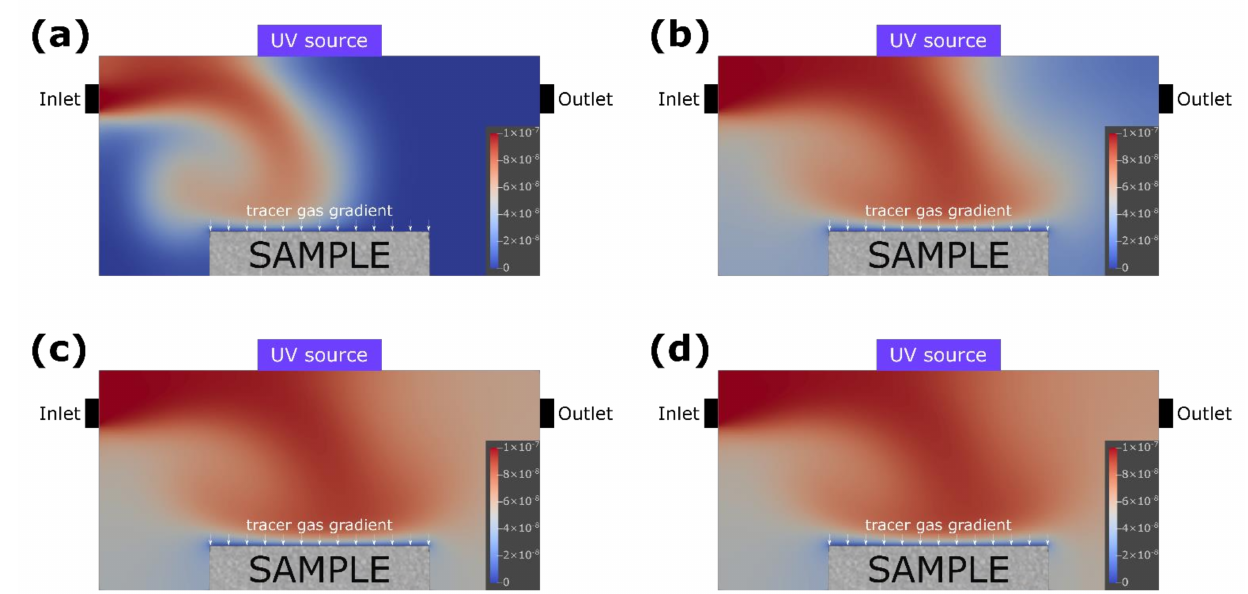
Figure 4. The relative concentration of the tracer gas in the reactor having a photocatalytic sample at the bottom presented on a two-dimensional cross section of the computational domain in the axes of the inlet and outlet at specific time steps: ( a ) 10 s, ( b ) 1 min, ( c ) 3 min, and ( d ) 10